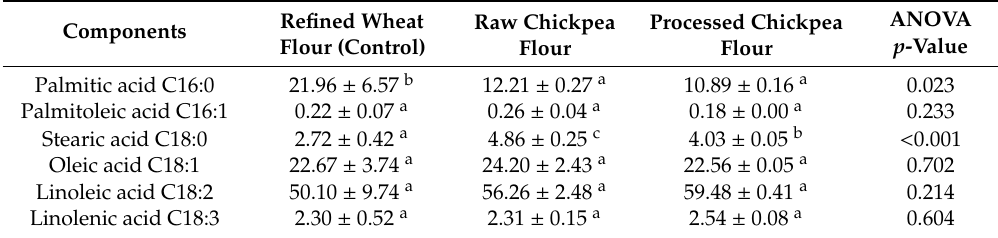
Table 3. Fatty acid content (%) of refined wheat flour, as well as raw and processed chickpea flours. Refined Components